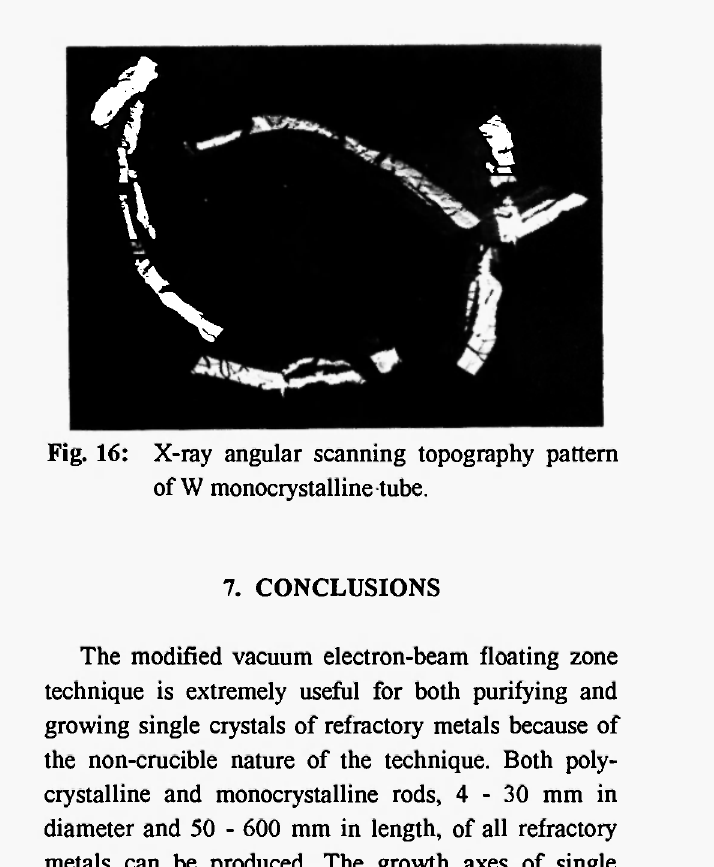
Fig. 14: Micrograph of large-angle grain boundary in W polycrystalline tube.